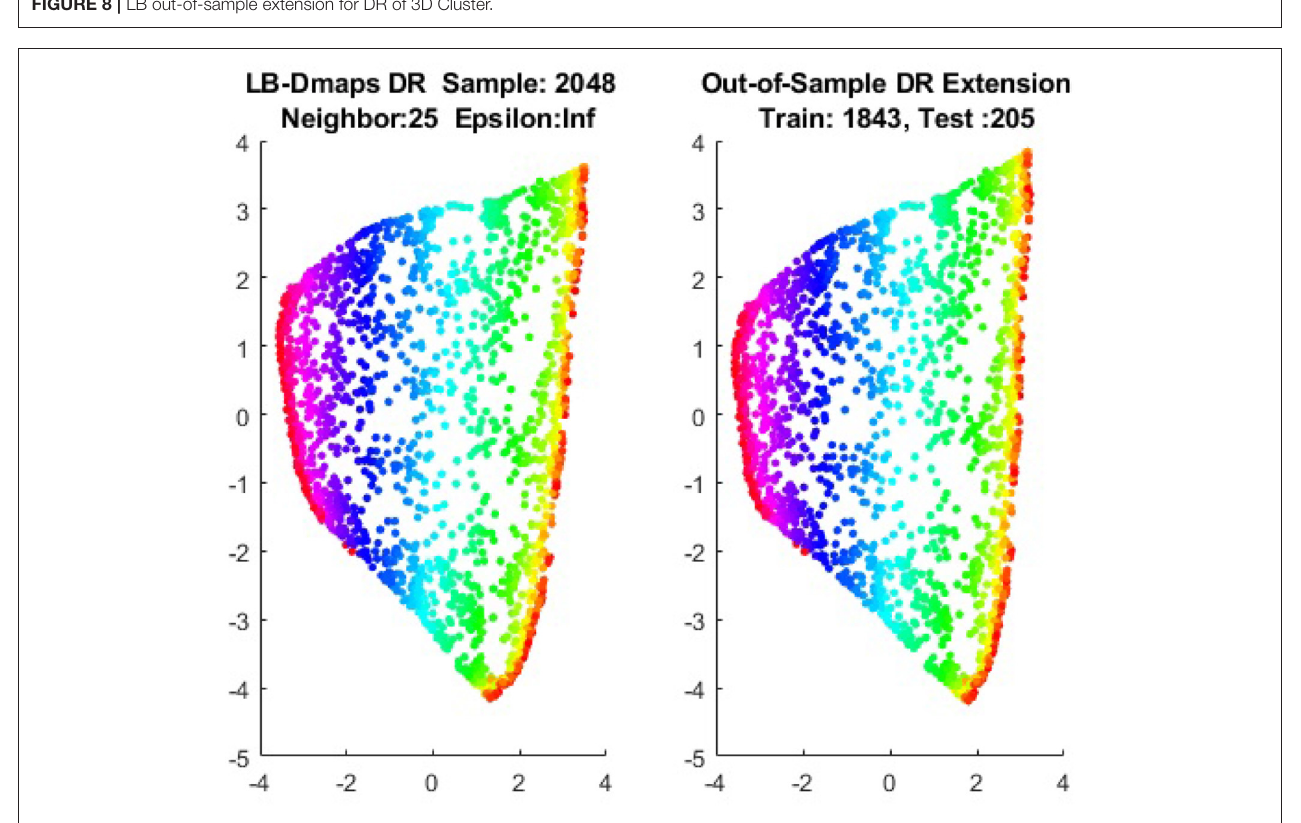
FIGURE 8 | LB out-of-sample extension for DR of 3D Cluster.